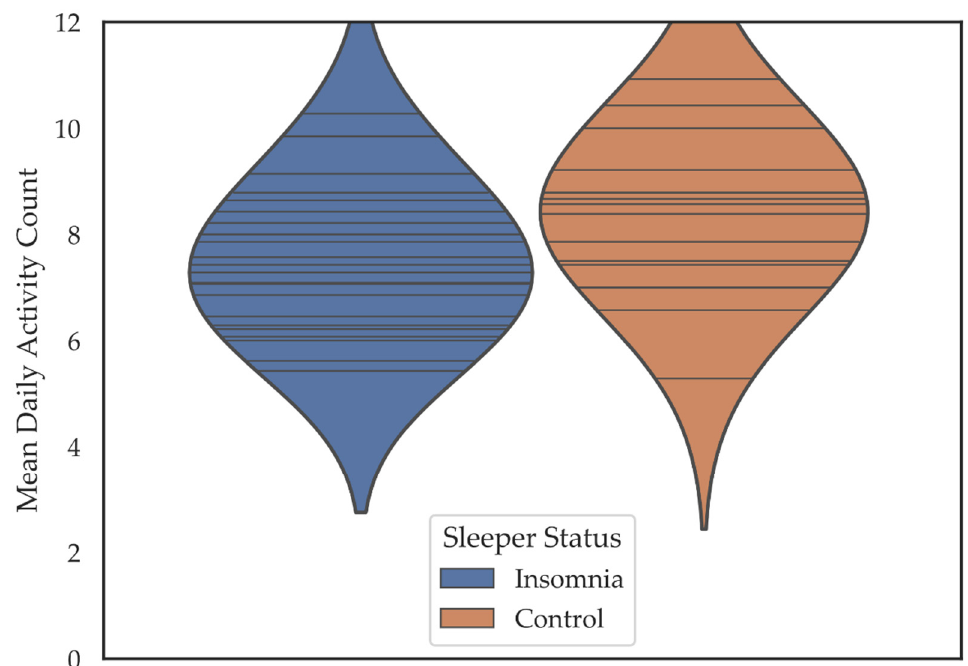
Figure 2. Violin plots depicting the mean daily activity participation count for individuals in the insomnia and control groups. Horizontal lines are individual data points. Colored regions are the Gaussian kernel density estimates (KDE) with bandwidth equal to one standard deviation of the data.